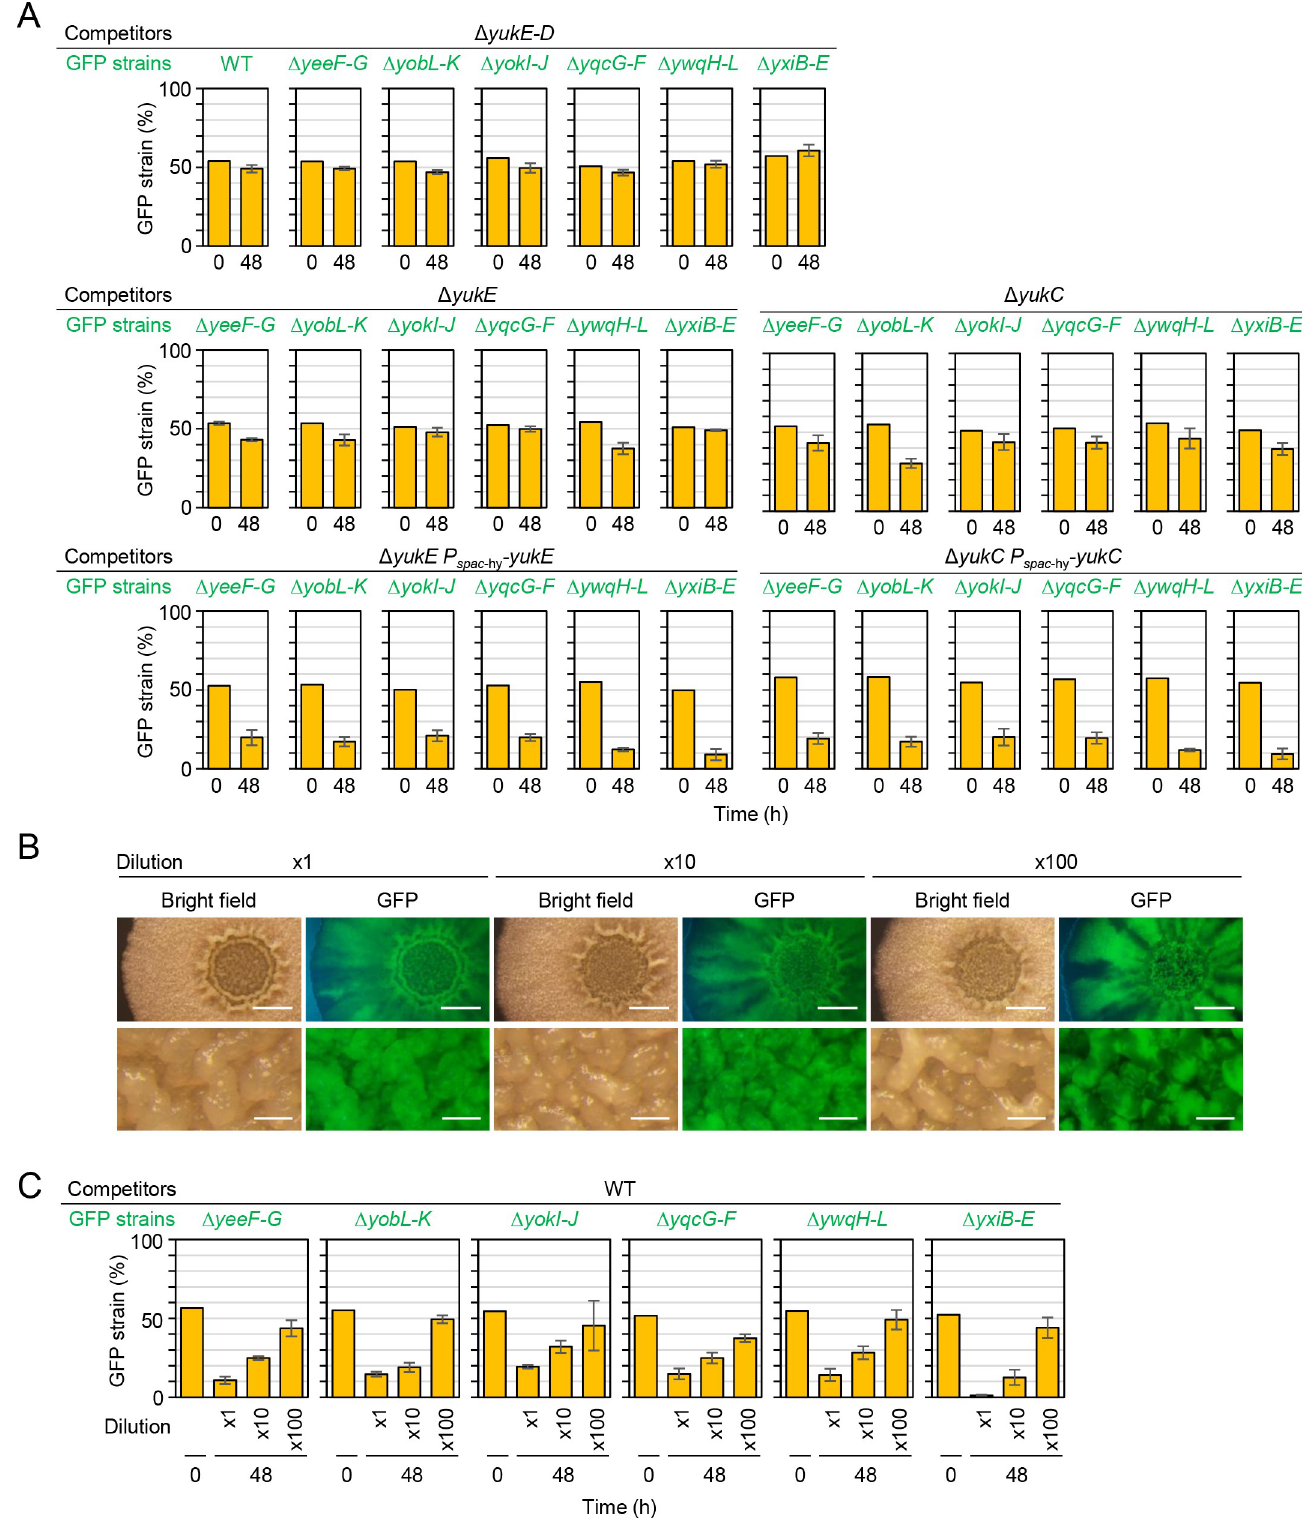
Fig 5. T7SS is required for LXG toxin delivery. (A) Competition assays between LXG toxin–antitoxin deletion mutants and T7SS mutants. Strains were co- cultured for 48 h on MSgg. Competition assays using Δ yukE P